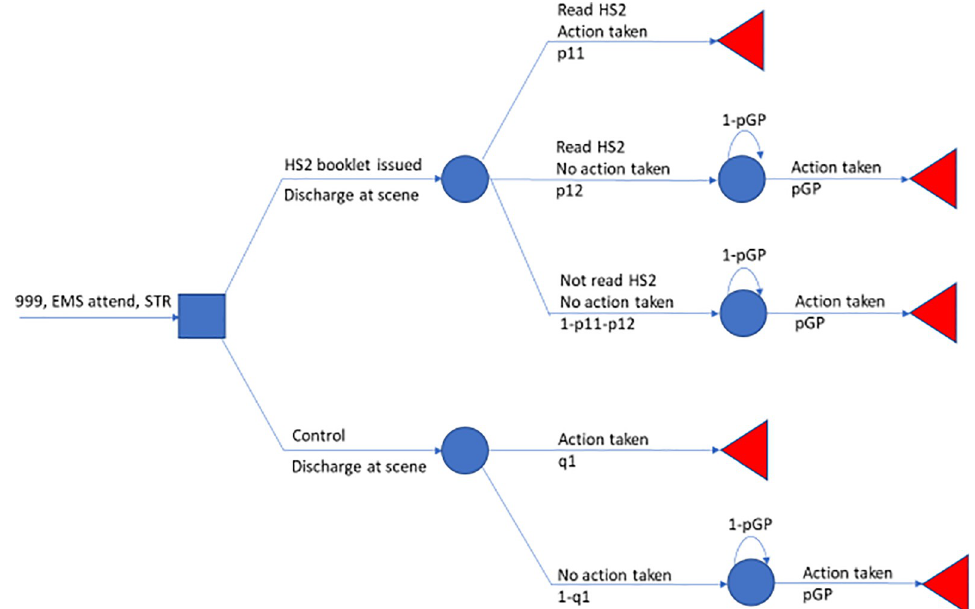
Fig 2. Cost minimisation model. Model is depicted by patient types in the HS2 intervention arm and in the standard care arm. Once the first fortnight-length cycle concludes exposure to risk of recurrent hypoglycaemia in each subsequent cycle replicates until GP attendance, where the latter defines the absorbing event for the Markov